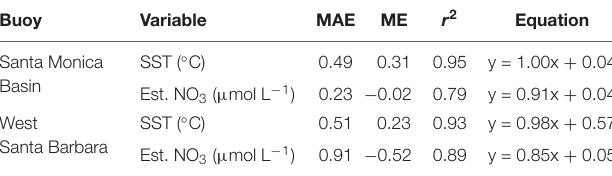
TABLE 1 | The mean absolute error (MAE), mean error (ME), coefficient of determination ( r 2 ), and linear equation for relationships between sea surface temperature (SST) and estimated nitrate concentration (Est. NO 3 ) between buoys and satellite determinations (1 km) MODIS/VIIRS-derived SST